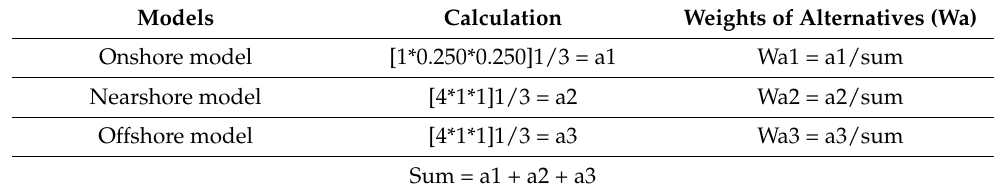
Table 9. Weights calculation of alternatives.